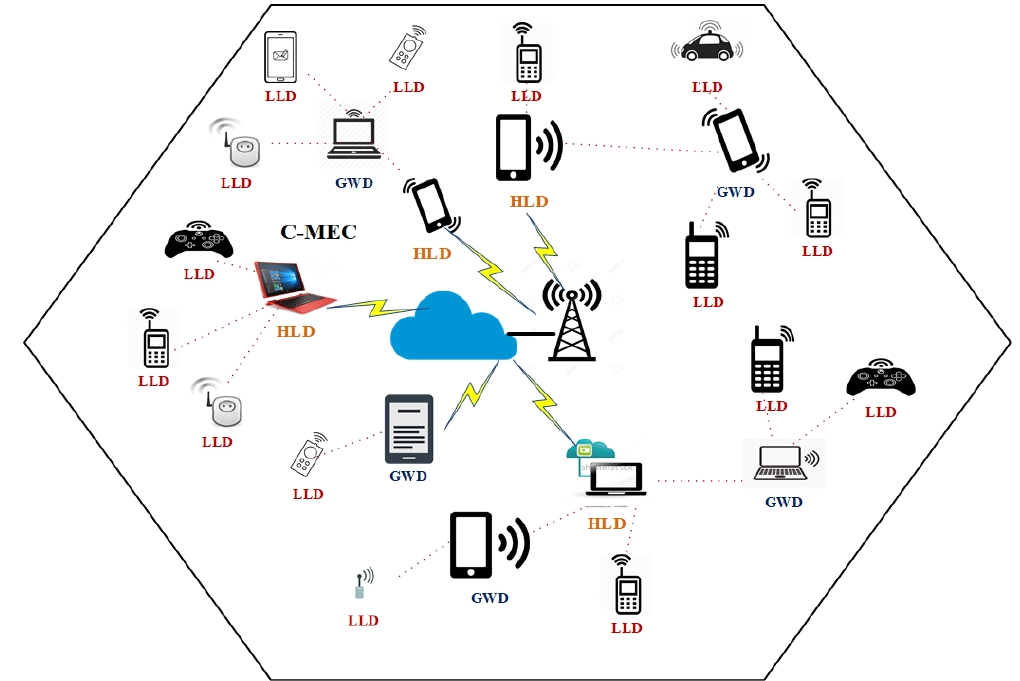
Figure 3. Device-to-Device communication (D2D) based network.